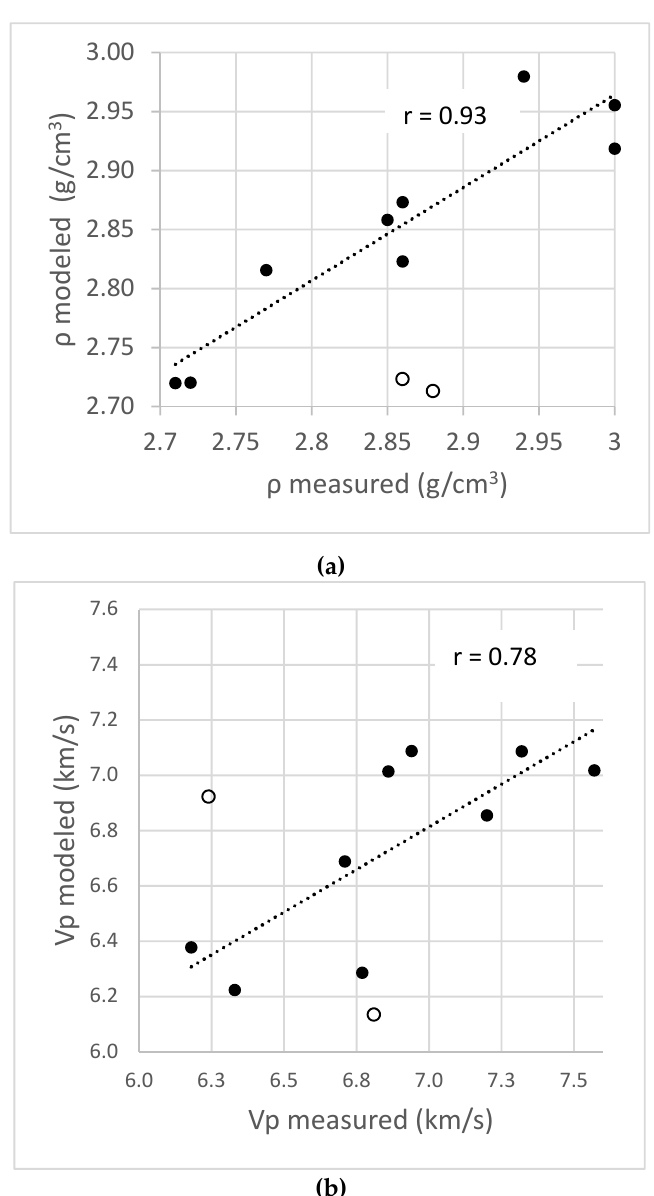
Figure 6. Scatter plots comparing the measured and modeled seismic rock properties. ( a ) Density; ( b ) P-wave velocity modeled by the average of the Voigt and Reuss bounds. Open circles indicate outliers not considered in the regression analysis.